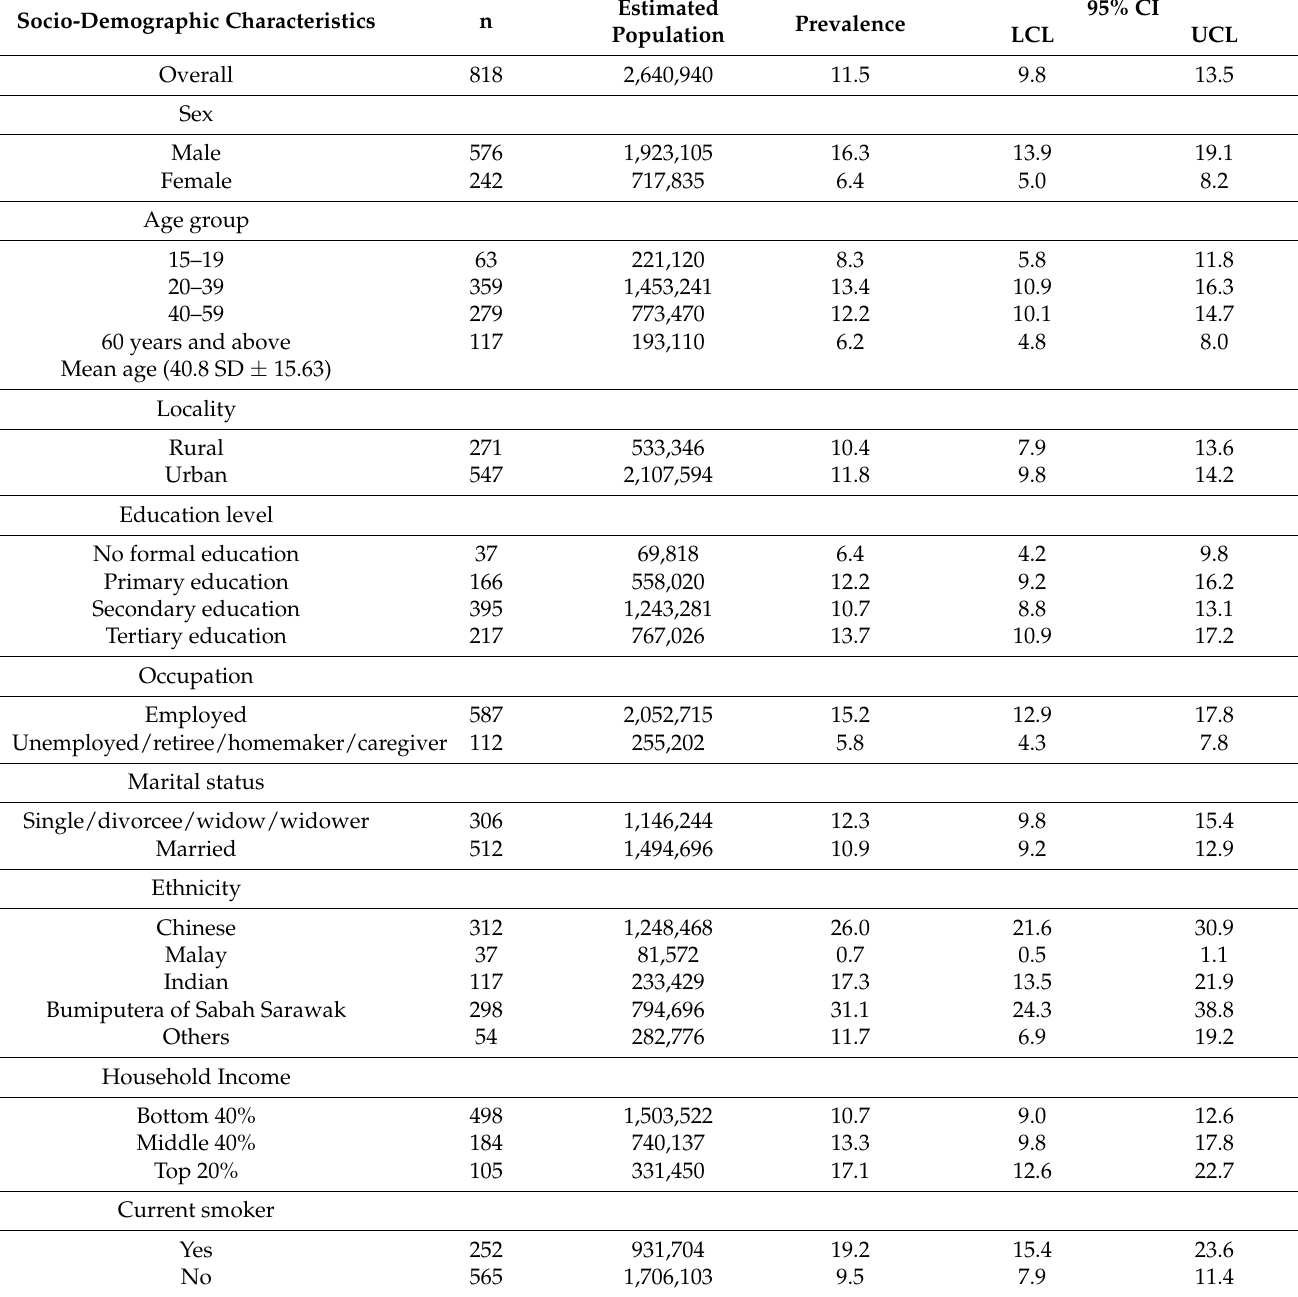
Table 1. Socio-demographic characteristics of current drinkers in Malaysia aged 15 and